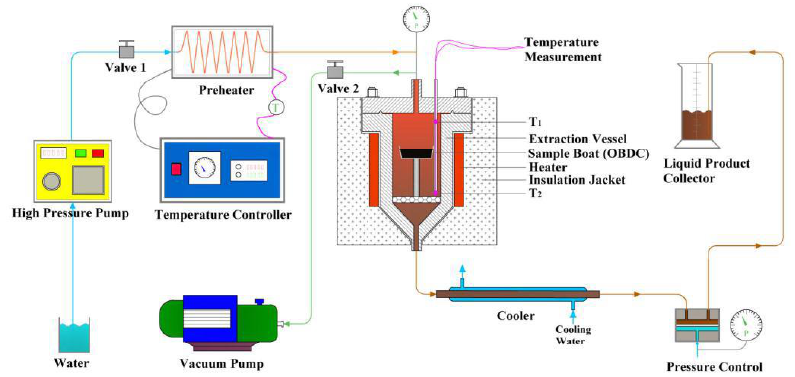
Figure 1 . Schematic of the experimental apparatus superheated steam extraction Supercritical water oxidation of polychlorinated biphenyls using hydrogen